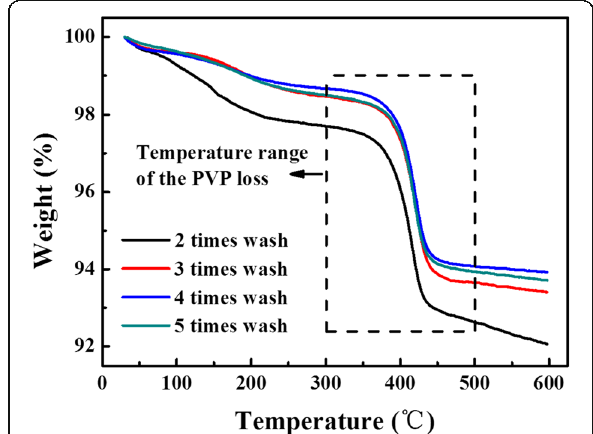
Fig. 3 TGA curves of the Ag NP suspensions of S1 with respect to washing times